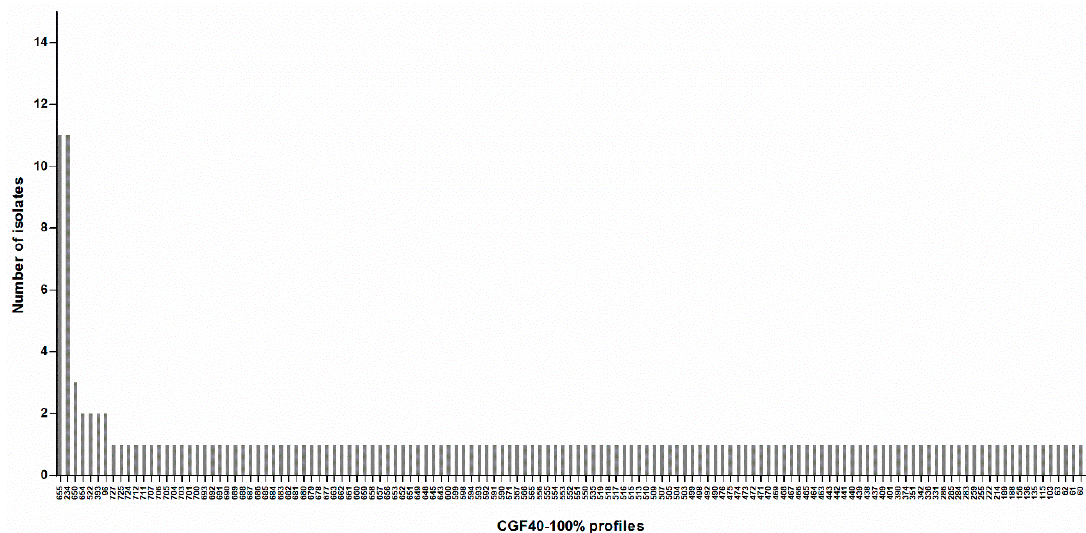
Figure 3. Distribution of CGF40-100% profiles within 161 C. jejuni isolates from cats and dogs in France. Labels on the X-axis correspond to the CGF40-100% cluster number.